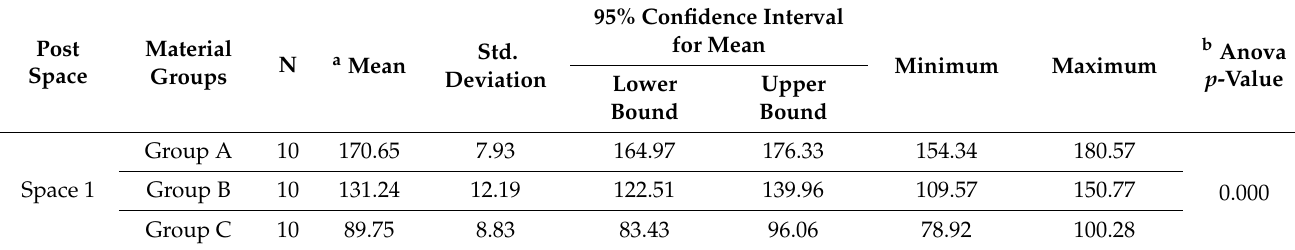
Table 6. Comparison of the tensile bond strength of the tested post materials with different post spaces (N = 90).